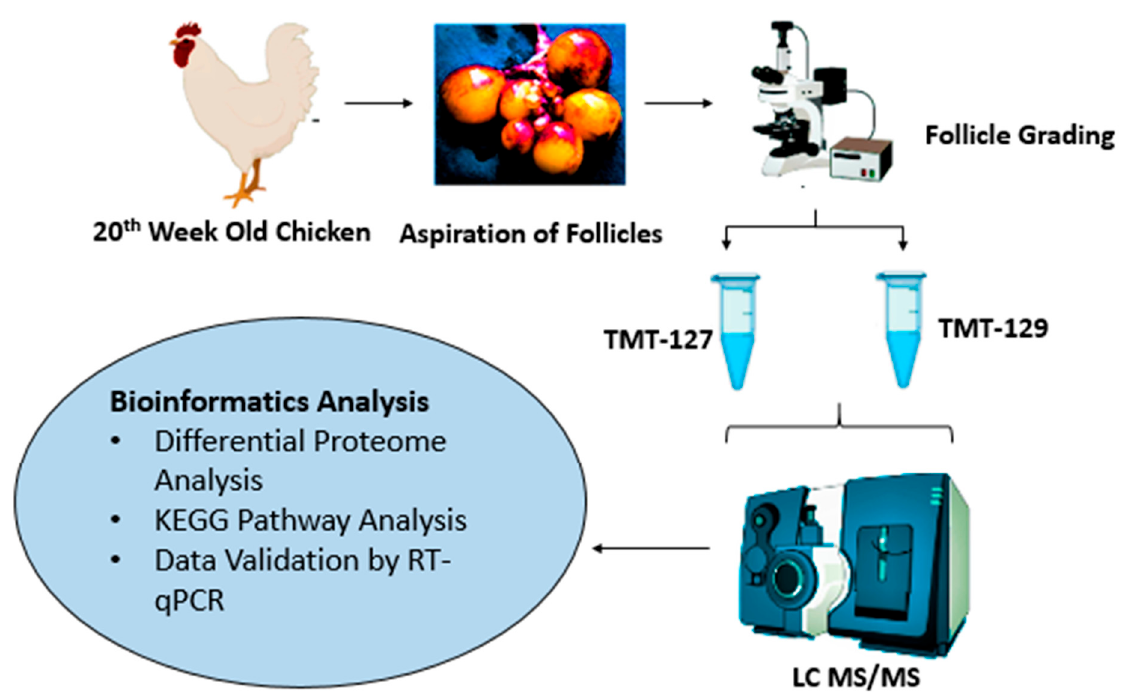
Figure 1. Schematic illustration of experimental design. Ovaries were isolated from 20-week-old chickens. The small follicles were aspirated and divided into two groups based on their— tandem mass tag (TMT)-127 indicates small primary follicles (81–150 μ m) and TMT-129 as developing primary follicles (300–500 μ m). The proteomic analysis was conducted by using Liquid chromatography–mass spectrometry (LC—MS/MS). The obtained data were analyzed for differential expression of proteins. The differentially expressed proteins (DEPSs) were subjected to gene ontology analysis and Kyoto Encyclopedia of Genes and Genomes (KEGG) pathway analysis. The proteomic data were validated by real-time quantitative PCR.